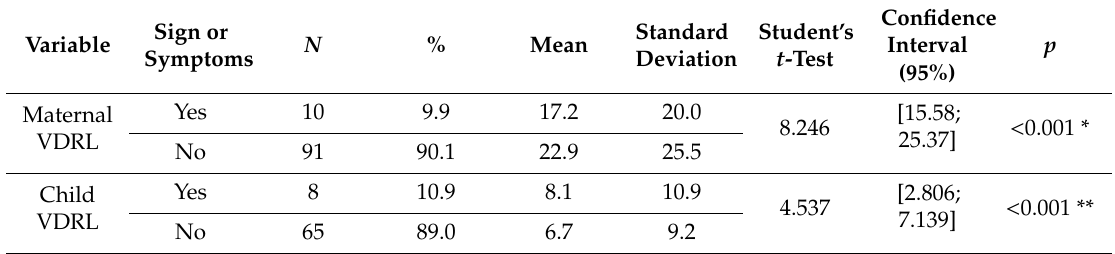
Confidence Standard Student’s p Interval t -Test Deviation (95%) [15.58; < 0.001 * 8.246 25.37] [2.806; < 0.001 ** 4.537 7.139]